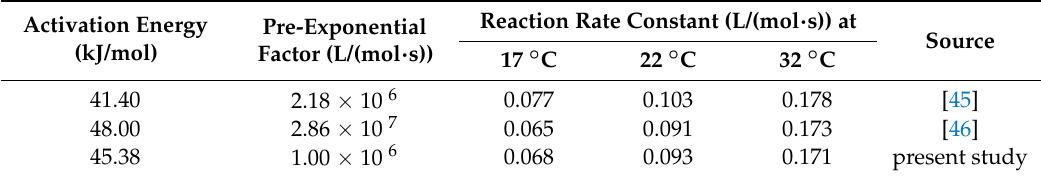
Table 4. Kinetic data of ethyl acetate saponification by sodium hydroxide.